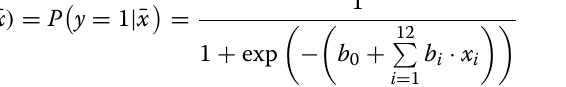
Machine learning based classification